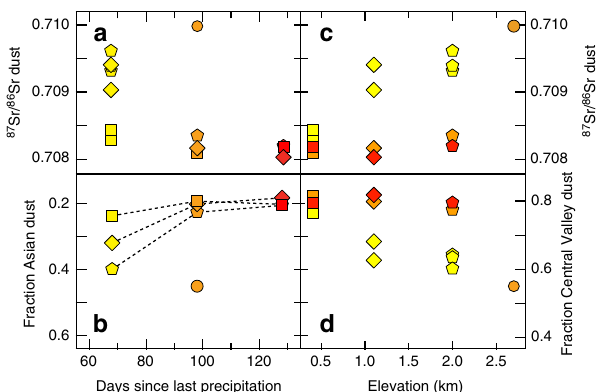
Figure 3 | Sr compositions and dust contributions. Seasonal record of strontium (Sr) isotopic composition and relative proportion of Central Valley dust to the total flux incident at the four sites, plotted as a function of time since last precipitation in the Central Valley (data from Friant Dam). Symbols for the four sites match those in Fig. 1: circles are Shorthair (elevation B 2,700m); pentagons are Providence (elevation B 2,000m); diamonds are Soaproot (elevation B 1,100m); and squares are SJER (elevation B 400m). Colours reflect passage of time during the sampling interval: yellow (July), orange (August) and red (September). ( a ) Sr data from multiple collectors in July indicate the variability in dust composition at a single site (s.d. of the mean of each sample measurement is o 0.0015). For sites with multiple months of data, Sr compositions trend towards less radiogenic compositions as the dry season progresses, towards the composition of the Central Valley (Fig. 2). ( b ) Relative proportions of Central Valley versus Asian dust calculated using the Sr compositions and two-component isotope mixing model. The low-elevation site is dominated by Central Valley dust ( B 80%) throughout the dry season, whereas the higher elevation sites decline in the relative contribution of Asian sources from as much as 40% early in the sampling interval to 20% at the end. ( c ) Sr isotopic composition as a function of elevation, indicating the general trend of more radiogenic compositions with higher elevation. ( d ) Relative proportions of Central Valley versus Asian dust as a function of elevation. The lowest elevation site has the largest fraction of Central Valley dust, while the highest elevation site has the largest fraction of Asian